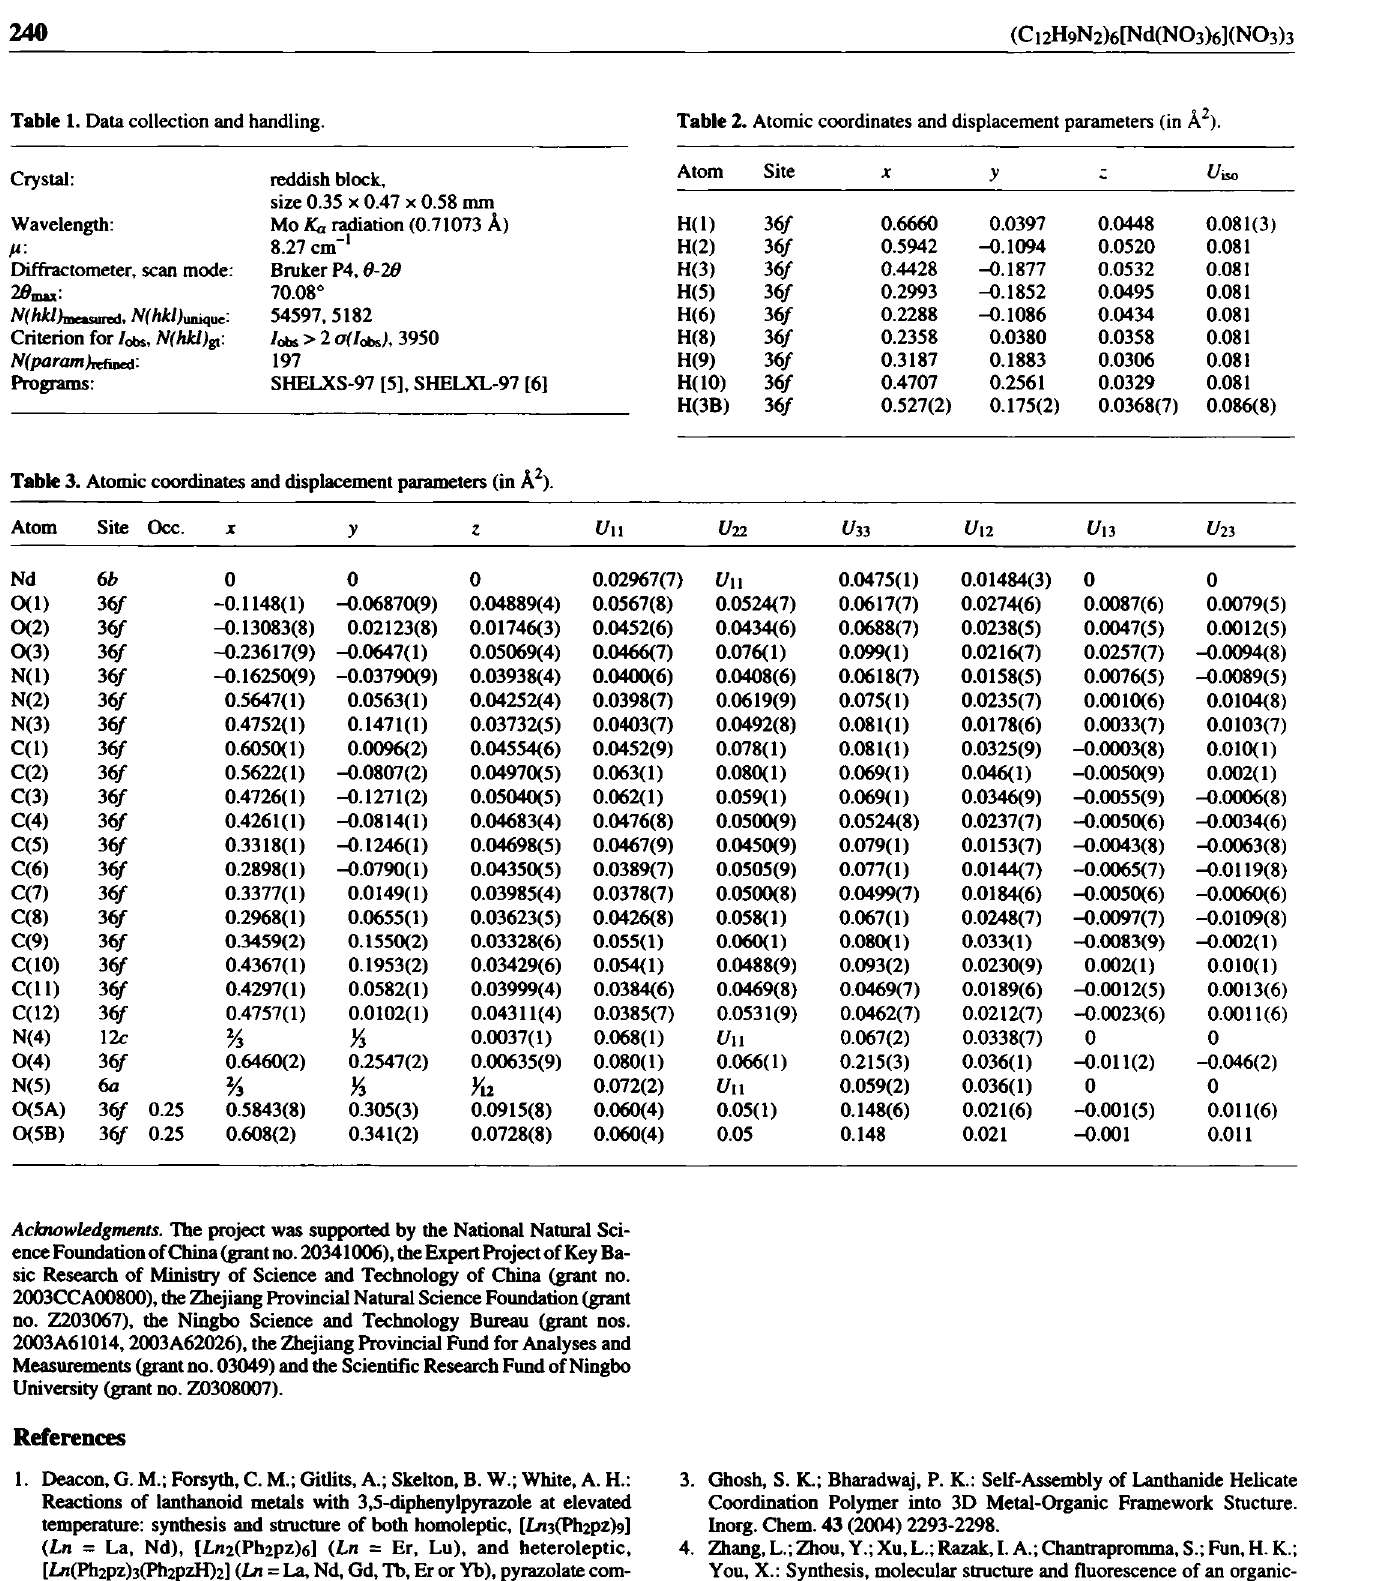
Table 1. Data collection and handling. Table 2. Atomic coordinates and displacement parameters (in A 2 ).